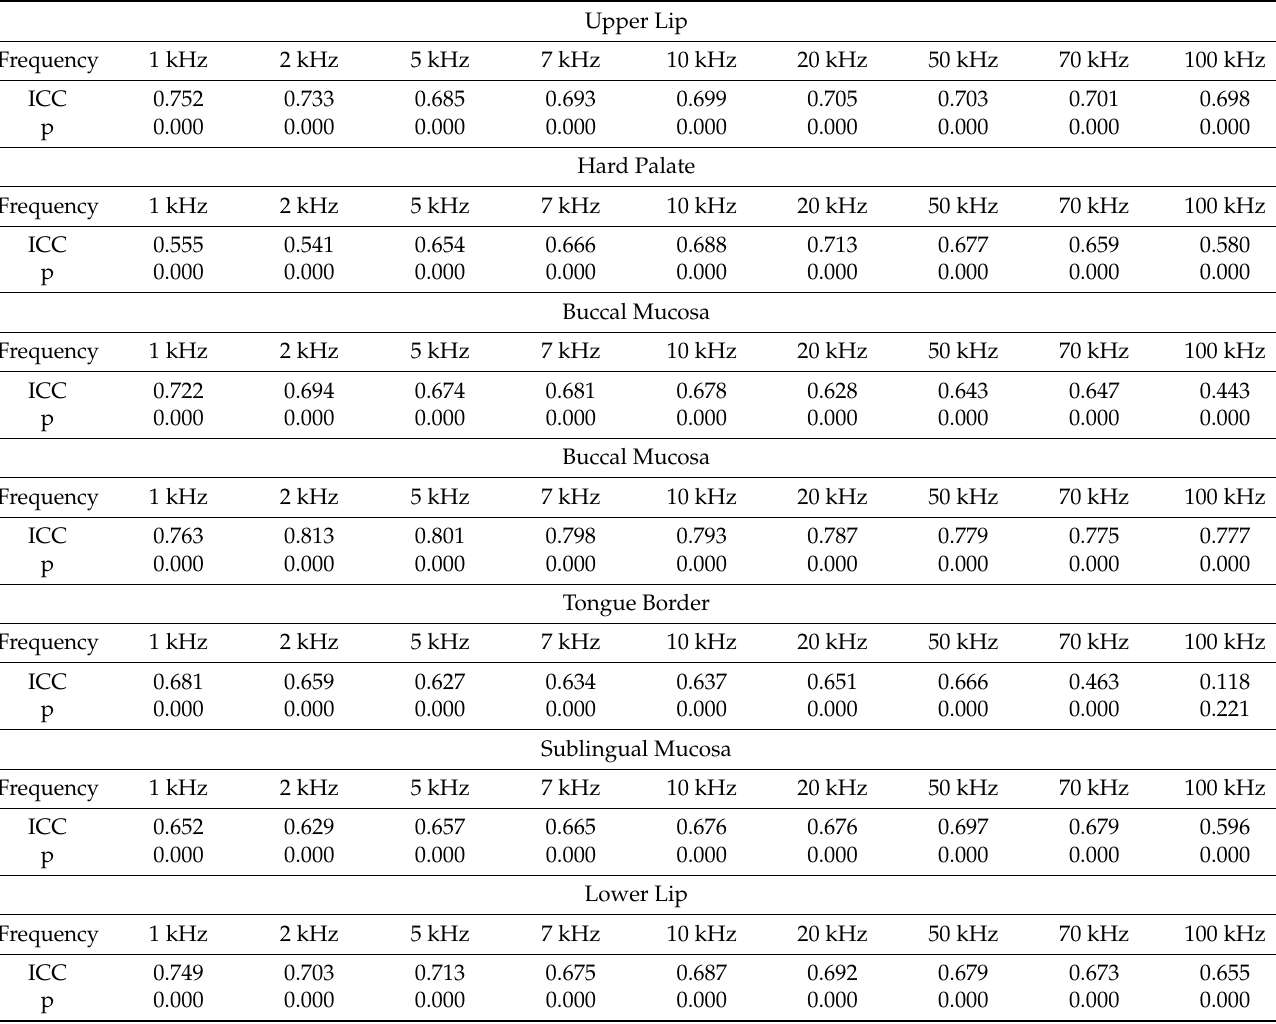
Table 2. Intra-rater statistics for measurements at the sub pressure of 250 mBar.